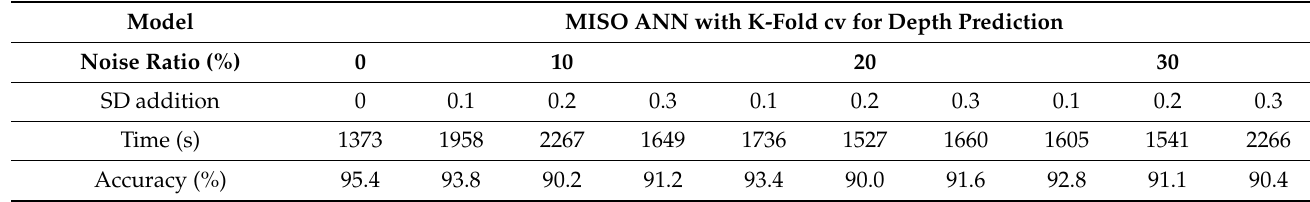
Table 19. Statistical tests of MISO ANN with K-fold cv model for depth prediction. Model MISO ANN with K-Fold cv for Depth